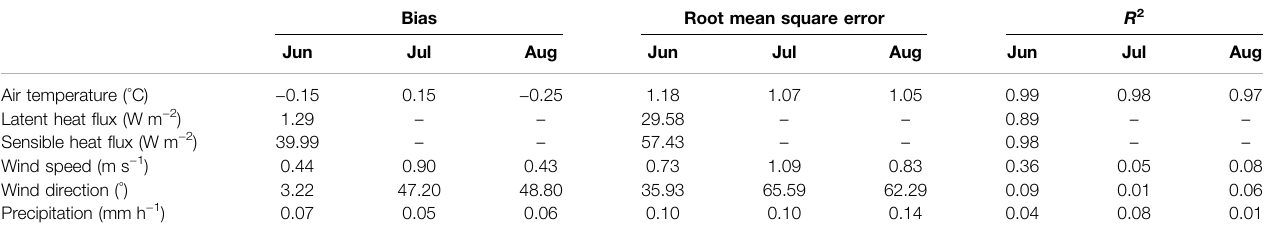
TABLE 2 | Bias, root mean square error, and R 2 between the WRF simulation and the site observation in June, July, and August 2013. The latent and sensible heat fl ux observations in July and August are missing, only June values are shown.